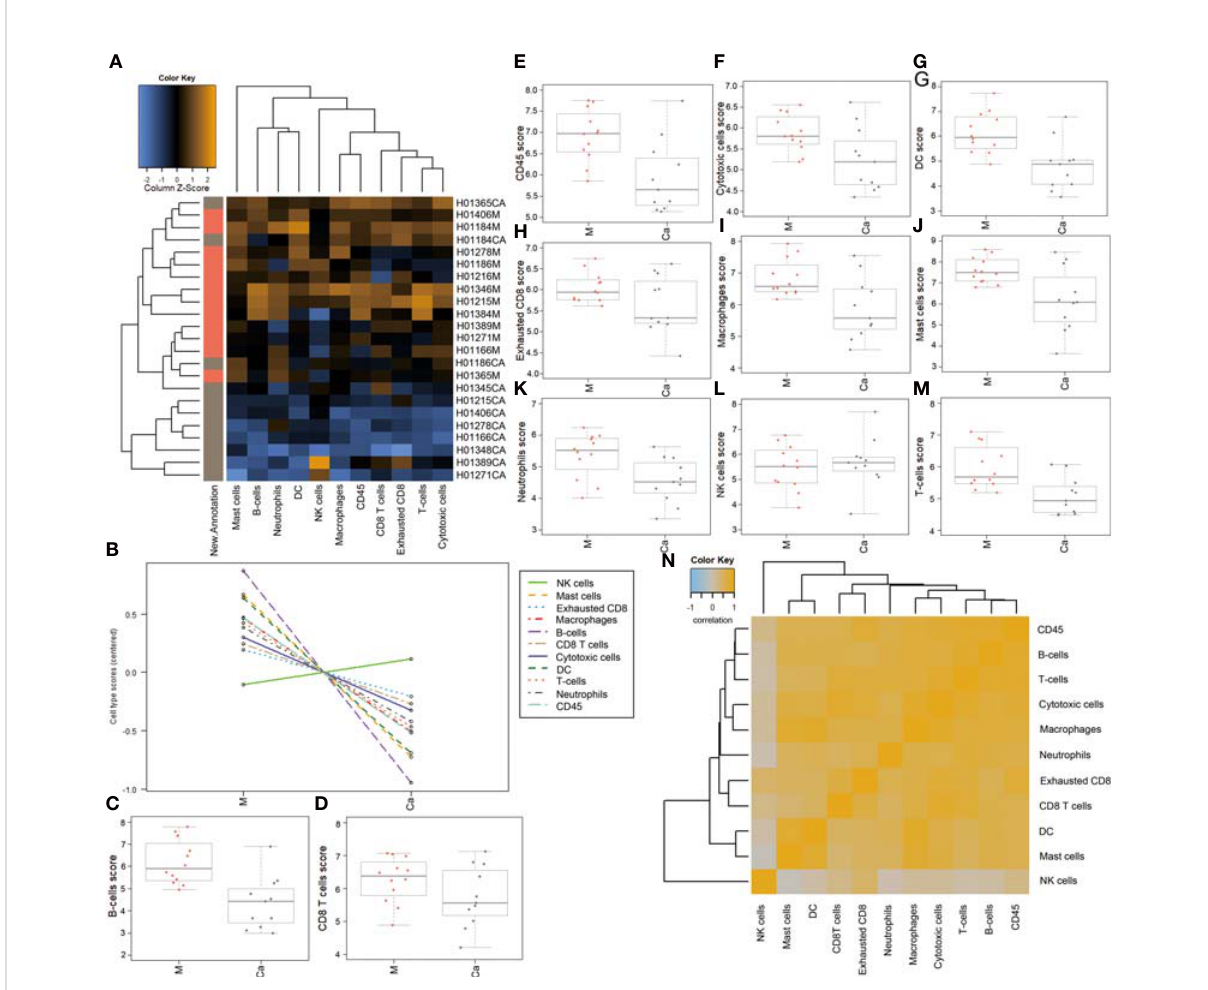
FIGURE 3 Abundance of immune cells in HSCC tissues and adjacent normal tissues. (A) Heatmap of raw cell type measurements. Orange indicates high abundance; blue indicates low abundance (B) Raw cell type measurements vs. New.Annotation. plots the raw cell type abundance measurements. (C) Plots B-cell measurements. (D) Plots CD8 cells measurements. (E) Plots CD45 measurements. (F) Plots cytotoxic cell measurements. (G) Plots DC measurements. (H) Plots exhausted CD8-cell measurements. (I) Plots macrophage measurements. (J) Plots mast- cell measurements. (K) Plots neutrophil measurements. (L) Plots NK-cell measurements. (M) Plots T-cell measurements. (N) Heatmap of the correlation matrix of raw cell type measurements. Heatmap showing the correlation matrix of raw cell abundance. Orange and blue indicate positive and negative correlations, respectively. Ordinate: log 2 TPM (Ca: HSCC tissues M: Adjacent normal